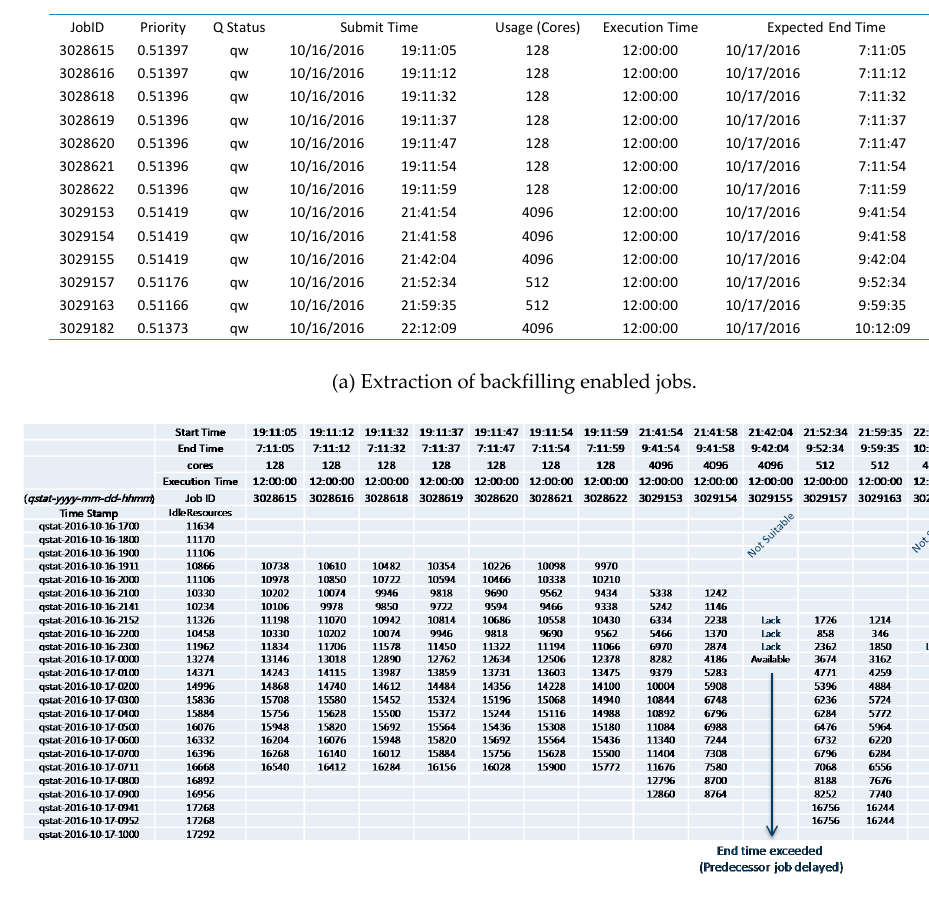
Figure 8. Applying backfilling for a large-scale job.